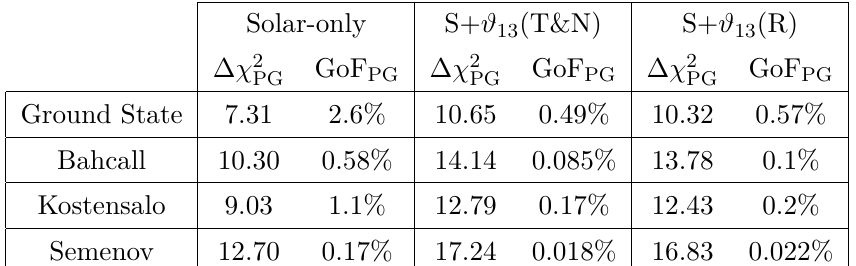
Table 6. χ 2 difference ∆ χ 2 of the parameter goodness of fit test [36] applied to the comparison of PG the solar neutrino bounds and the neutrino oscillation explanation of the Gallium data with the four Gallium detection cross sections in table 1. The values of the corresponding parameter goodness of fit GoF PG are calculated with two degrees of freedom corresponding to the two common oscillation parameters sin 2 2 ϑ ee and ∆ m 2 . The Solar-only, S+ ϑ 13 (T&N), and S+ ϑ 13 (R) column titles refer, 41 respectively, to the free sin 2 ϑ 13 analysis, the analysis with sin 2 ϑ 13 constrained by neutrino data from T2K and NOvA, and the analysis with sin 2 ϑ 13 constrained by reactor data.